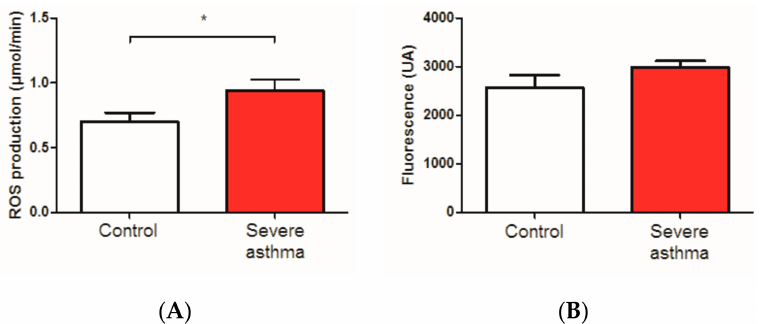
Figure 4. Reactive oxygen species (ROS) in control and severe asthmatic patients experiencing severe exacerbation. ( A ): total ROS level on whole blood was obtained using electron paramagnetic resonance. n = 16 per group. ( B ): ROS level on PBMC was detected by MitoSOX-based spectrofluorimetry detection. Results are expressed as means ± standard error of the mean (SEM). n = 8 per group. * p < 0.05.